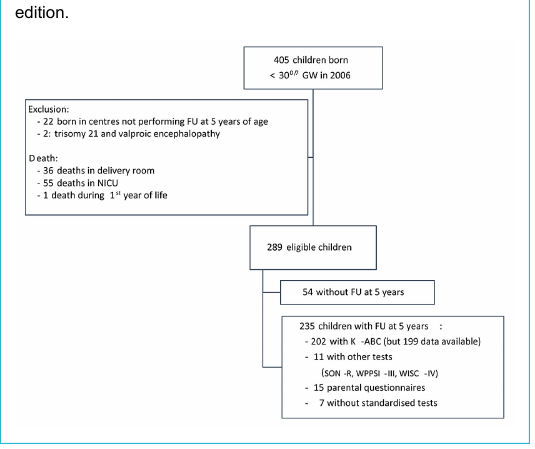
Figure 1: Study recruitment and follow-up.GW = gestational weeks; FU = follow up; NICU = neonatal intensive care unit; K- ABC = Kaufman Assessment Battery for Children, first edition; SON-R = Snijders-Oomen non-verbal intelligence tests; WPPSI-III = Wechsler Preschool and Primary Scale of Intelligence, third edi- tion; WISC-IV = Wechsler Intelligence Scale for Children, fourth